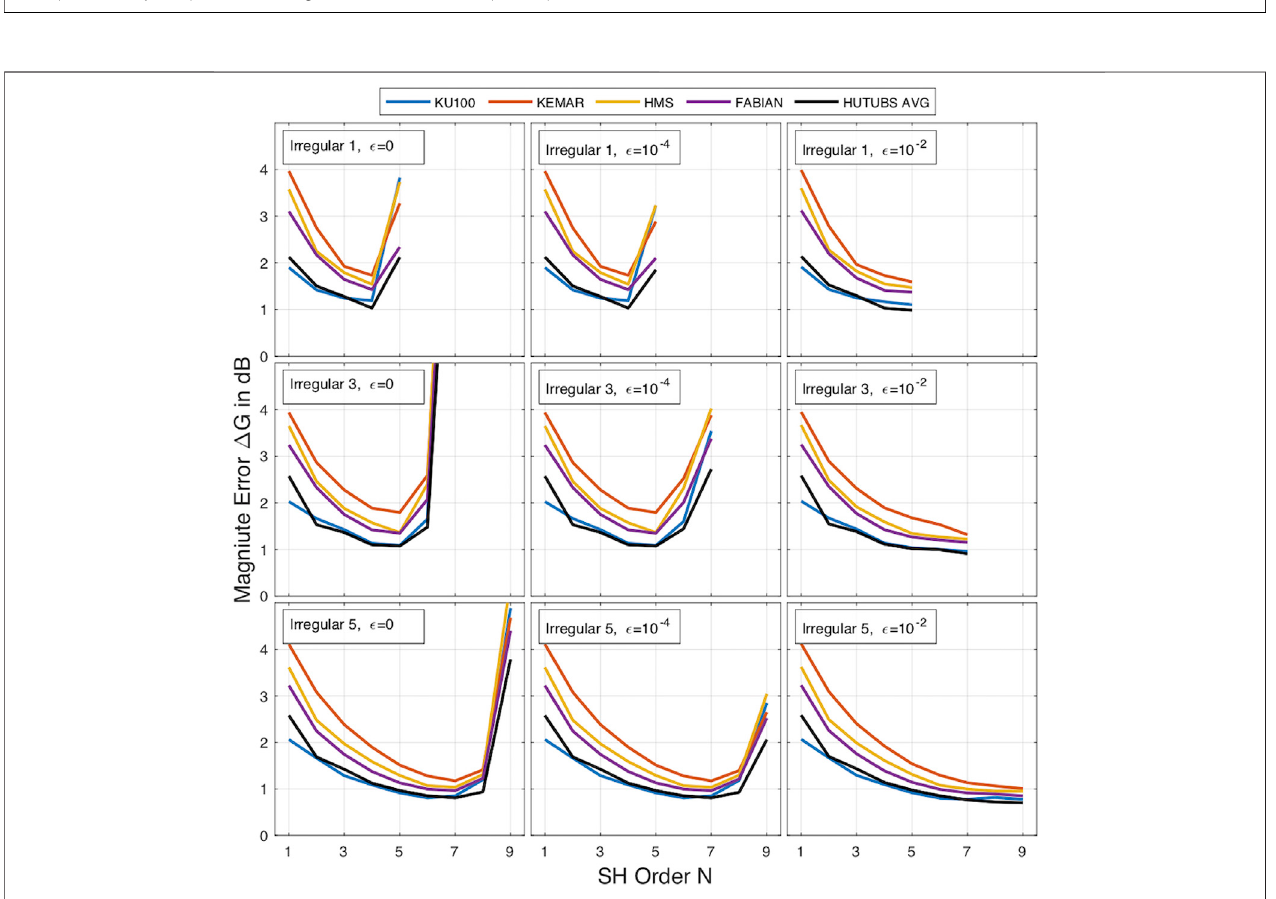
FIGURE6| Left-earmagnitudeerror Δ G withrespecttoSHorderfordifferentgenericHRTFsetsandtheaveragedHUTUBSHRTFsetforthreeexaminedirregular grids and different regularization values ϵ .